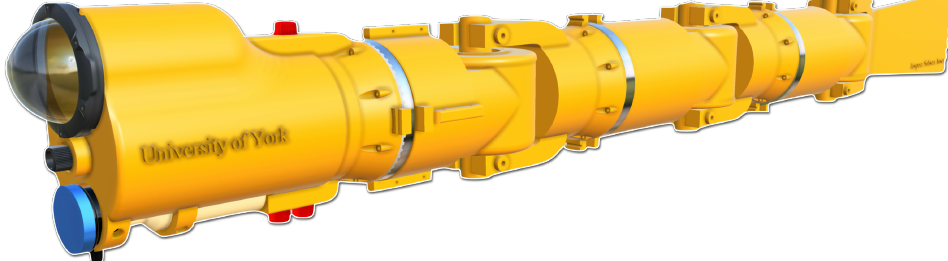
Figure 1. RoboFish CAD Model withf our modules: Head, Two Segments and